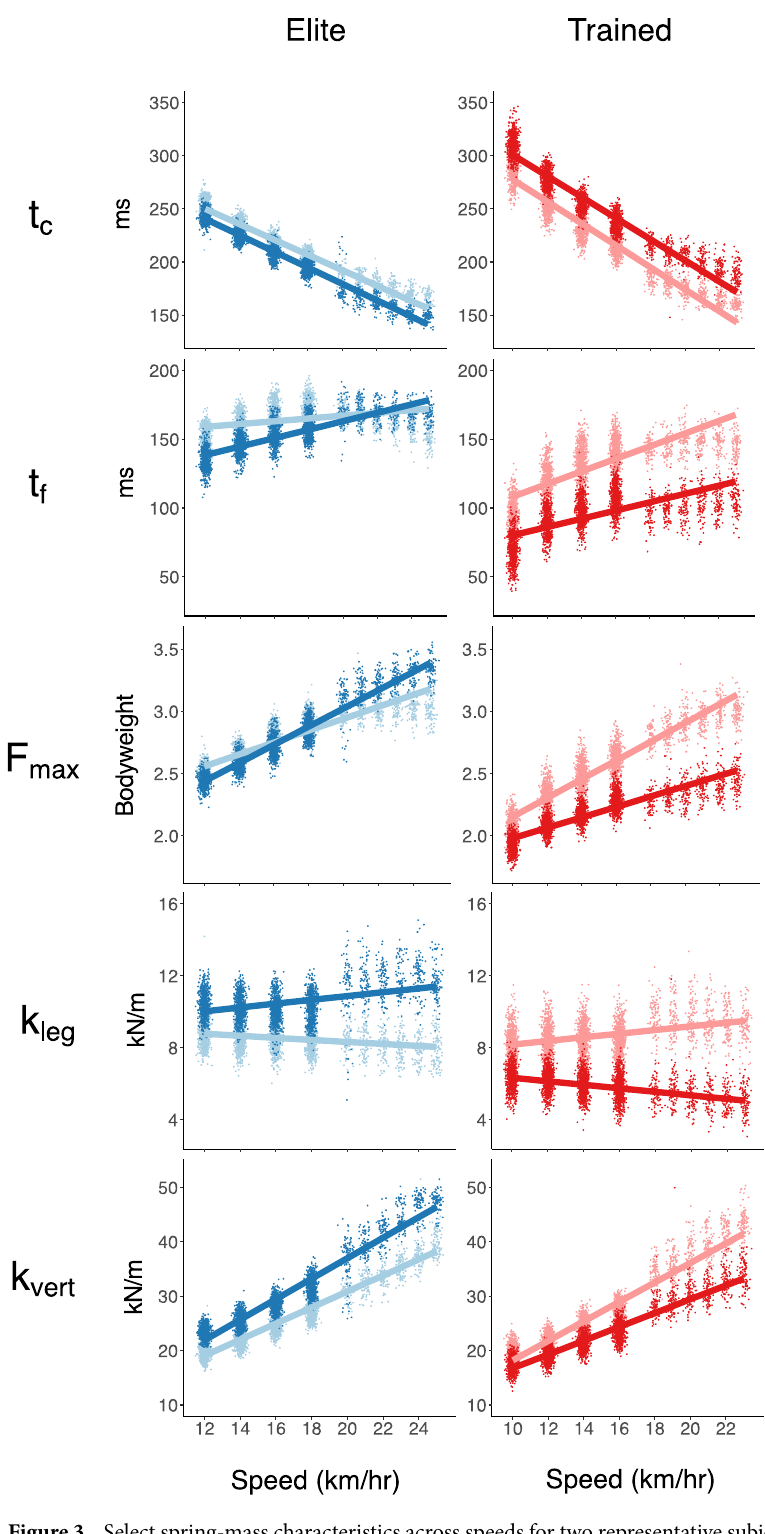
Figure 3. Select spring-mass characteristics across speeds for two representative subjects for the elite (left) and trained 67